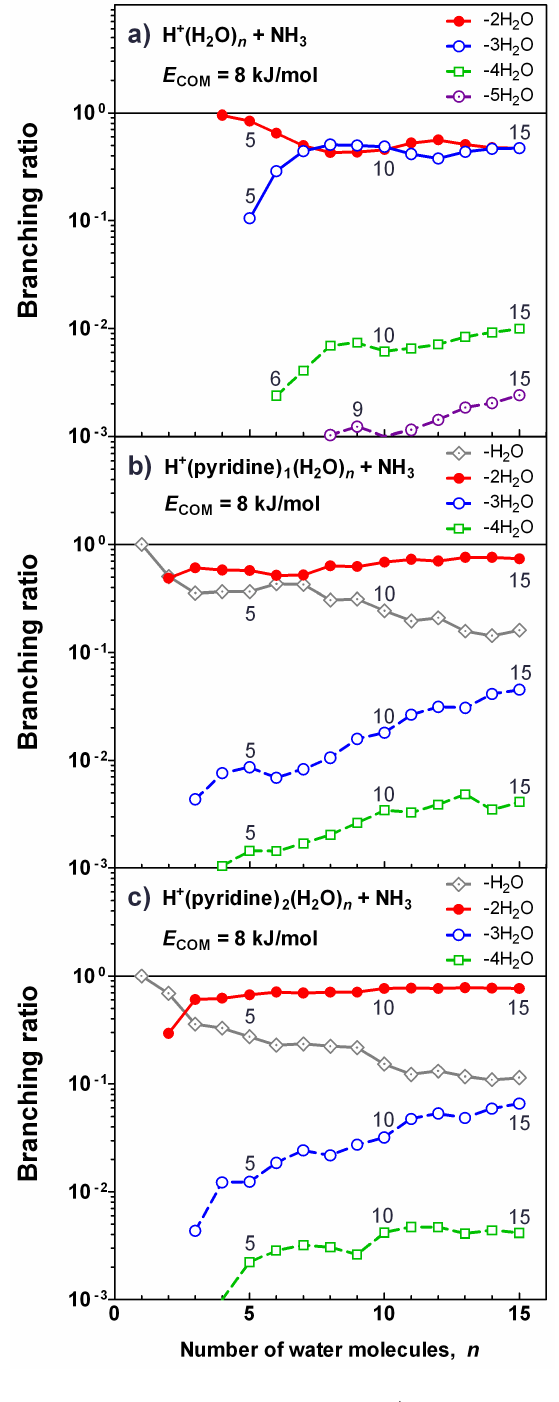
Fig. 4. Branching ratios for the reactions of H + (pyridine) m (H 2 O) n ( m = 0 to 2) with NH 3 at E COM = 8kJmol − 1 . The number of wa- ter molecules, n , is indicated for some of the data points to im- prove readability. Dashed lines indicate products likely resulting from clusters that have lost water molecules prior to reaction.